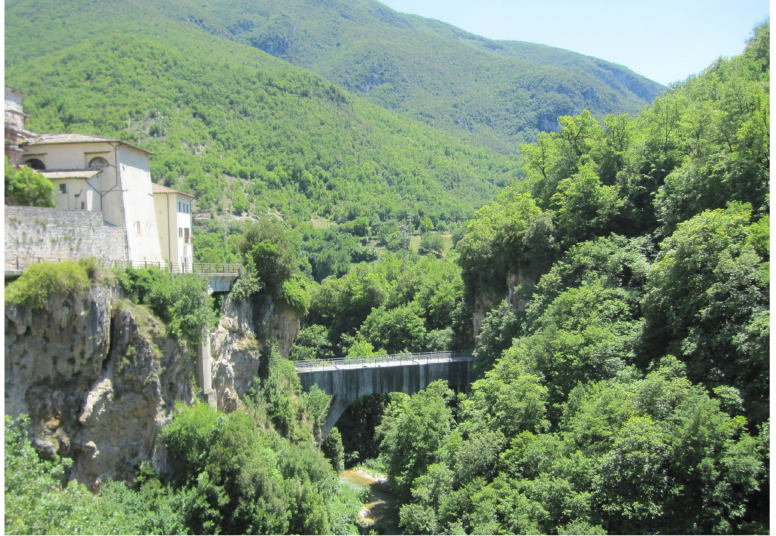
Figure 8. The final incision down to the bedrock of the Holocene tufa dam of Triponzo (Central